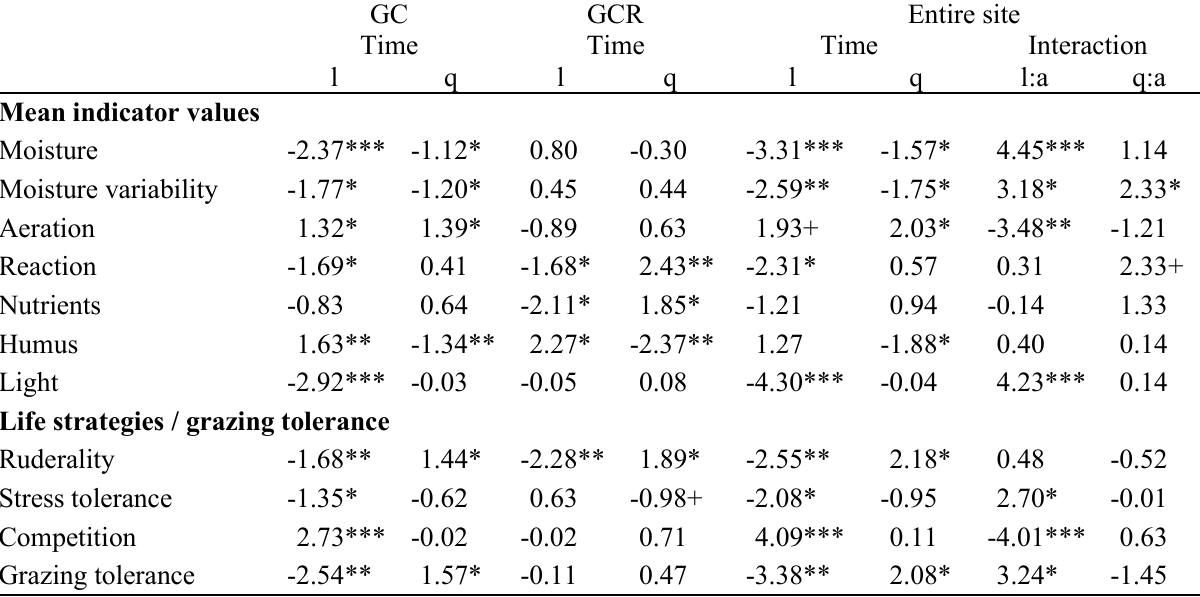
Table 2. Trends of mean indicator values, life strategies and grazing tolerance in the two areas (GC and GCR) and the entire site. Results of separate regression models for the GC-area and GCR-area, as well as results from the combined model, are shown. Numbers a re the effect sizes of the orthogonal polynomials of time and their interaction with area type. GC = grazing cessation; GCR = grazing cessation and rewetting; l = linear term; q = quadratic term; l:a = interaction linear term between time and area type. q:a = interaction quadratic term between time and area type. Significance levels: +: p ≤ 0.1; *: p ≤ 0.05; **: p ≤ 0.01; ***: p ≤